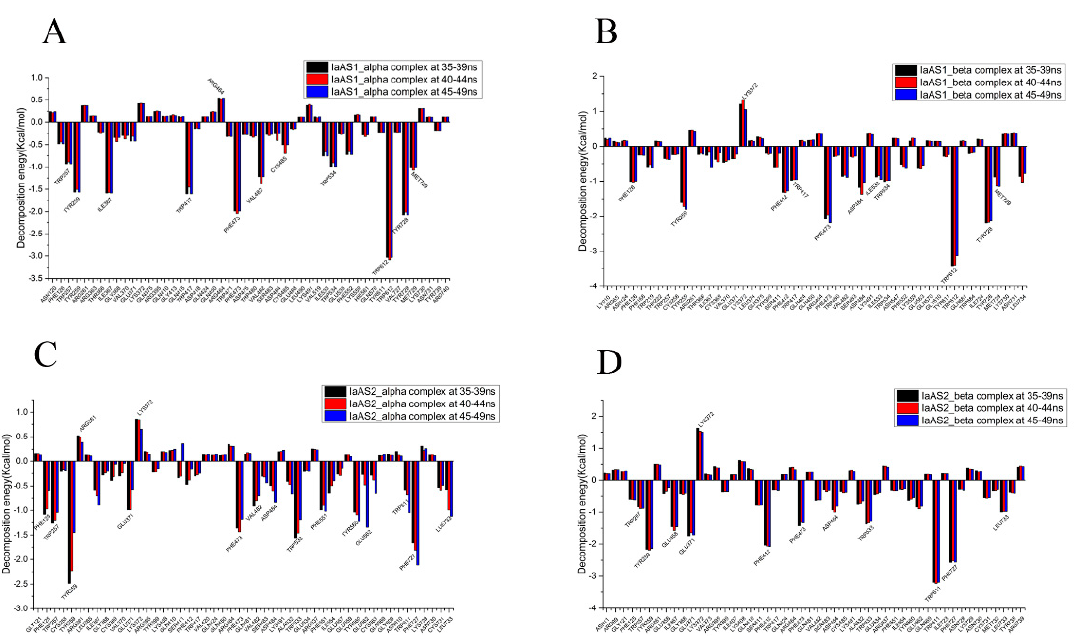
Figure 4. Decomposition of binding free energy of each residue for IaAS1_alpha ( A ), IaAS1_beta ( B ), IaAS2_alpha ( C ), and IaAS2_beta ( D ).